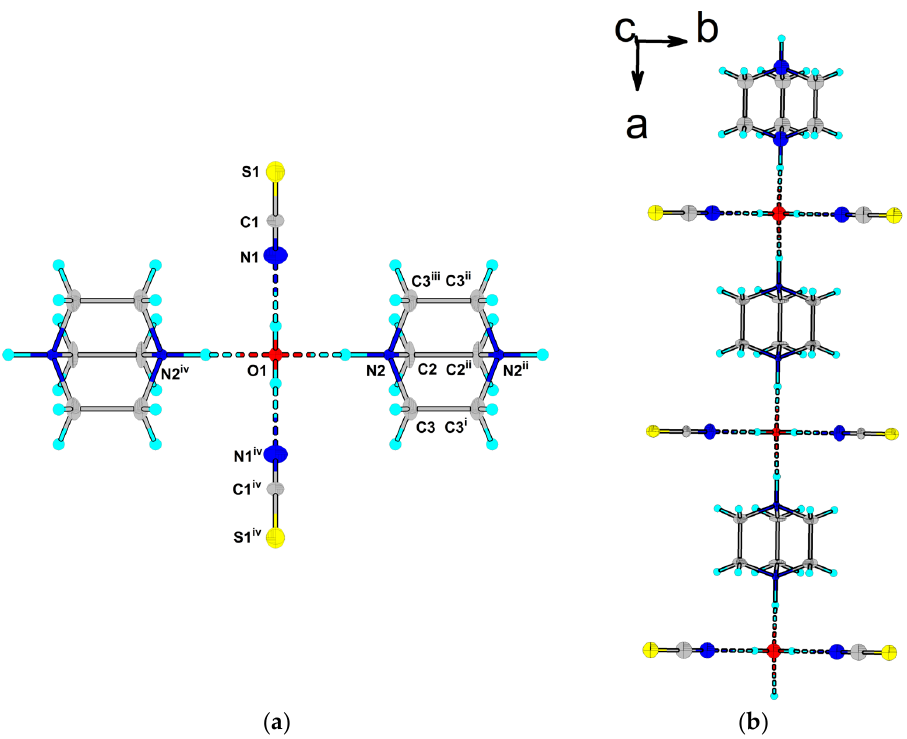
Figure 9. ( a ) Water molecule surrounded by two H 2 dabco 2+ and two SCN − moieties in structure 7 . Thermal ellipsoids are drawn at the 50% probability level. ( b ) Infinite chains {H 2 dabco 2+ –H 2 O(SCN − ) 2 } n .